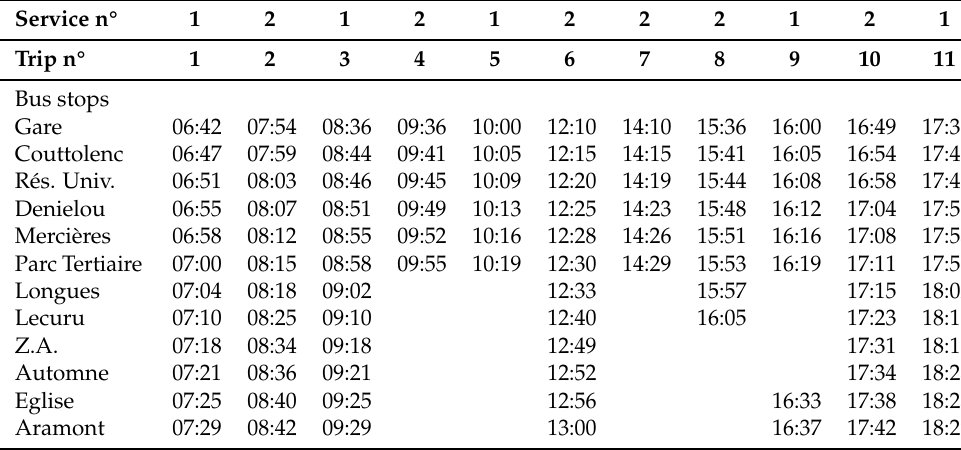
Figure 2. Scheme of a bus line with three terminals (in red), intermediate bus stops (in green), two routes (in blue and purple), and the time schedule of one trip on the purple route. Table 1. Timetable of bus line “ARC Express” in Compiègne, France